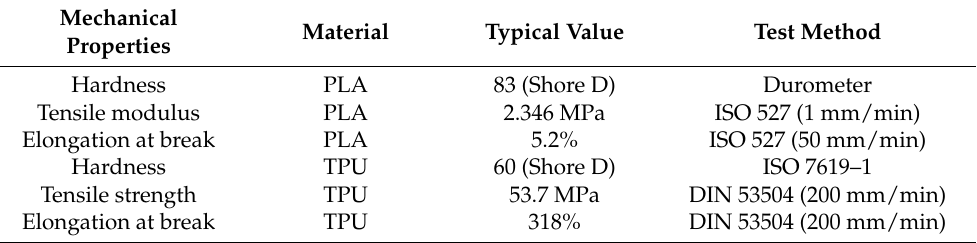
Table 1. Mechanical properties of PLA and TPU, referring to the technical data sheet [44,45].